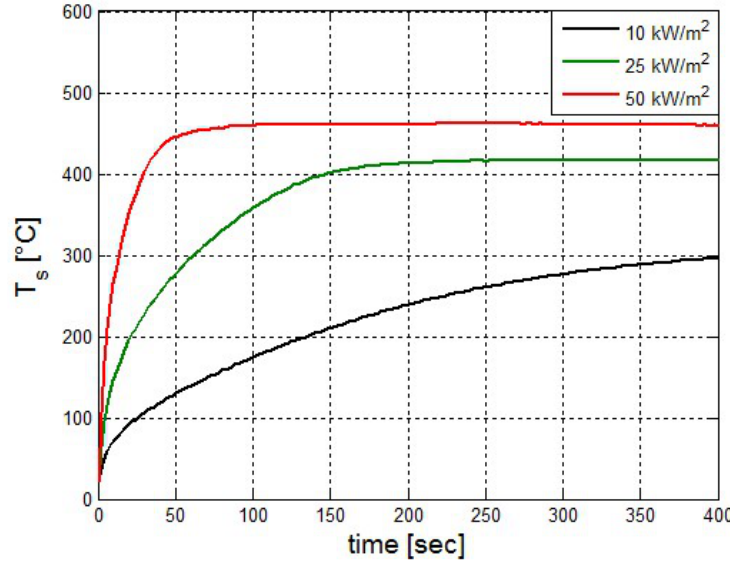
Figure 9. The surface temperatures of composite as a function of time for different heat fluxes. Figure 9 indicates that the surface temperature of the composite increases with heat flux.